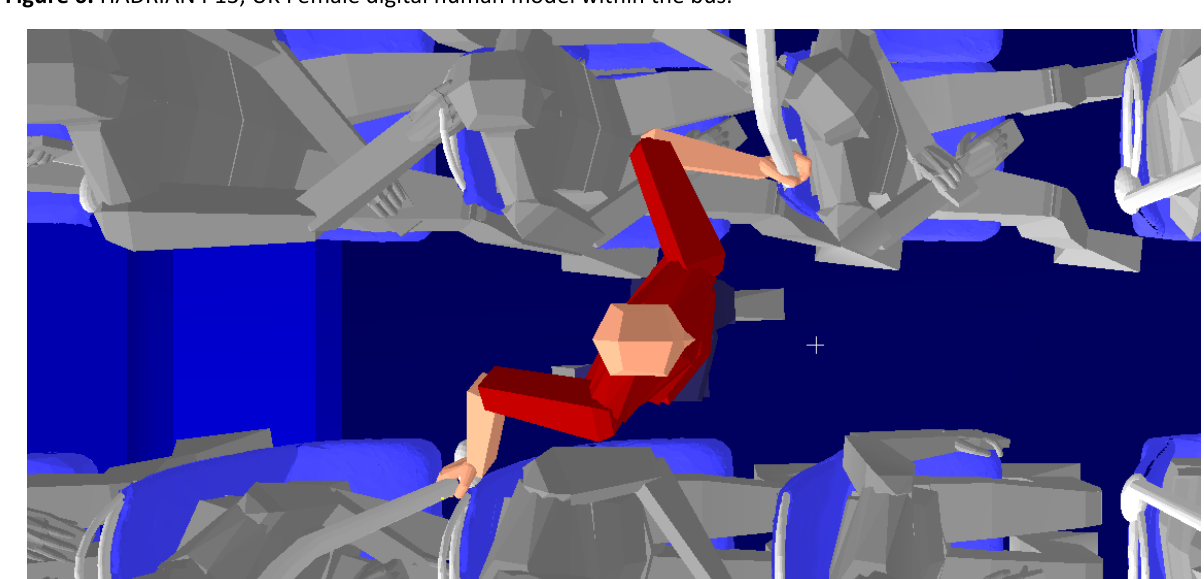
Figure 7. Human models would hold on to at least one hand hold within the vehicle whilst traversing.